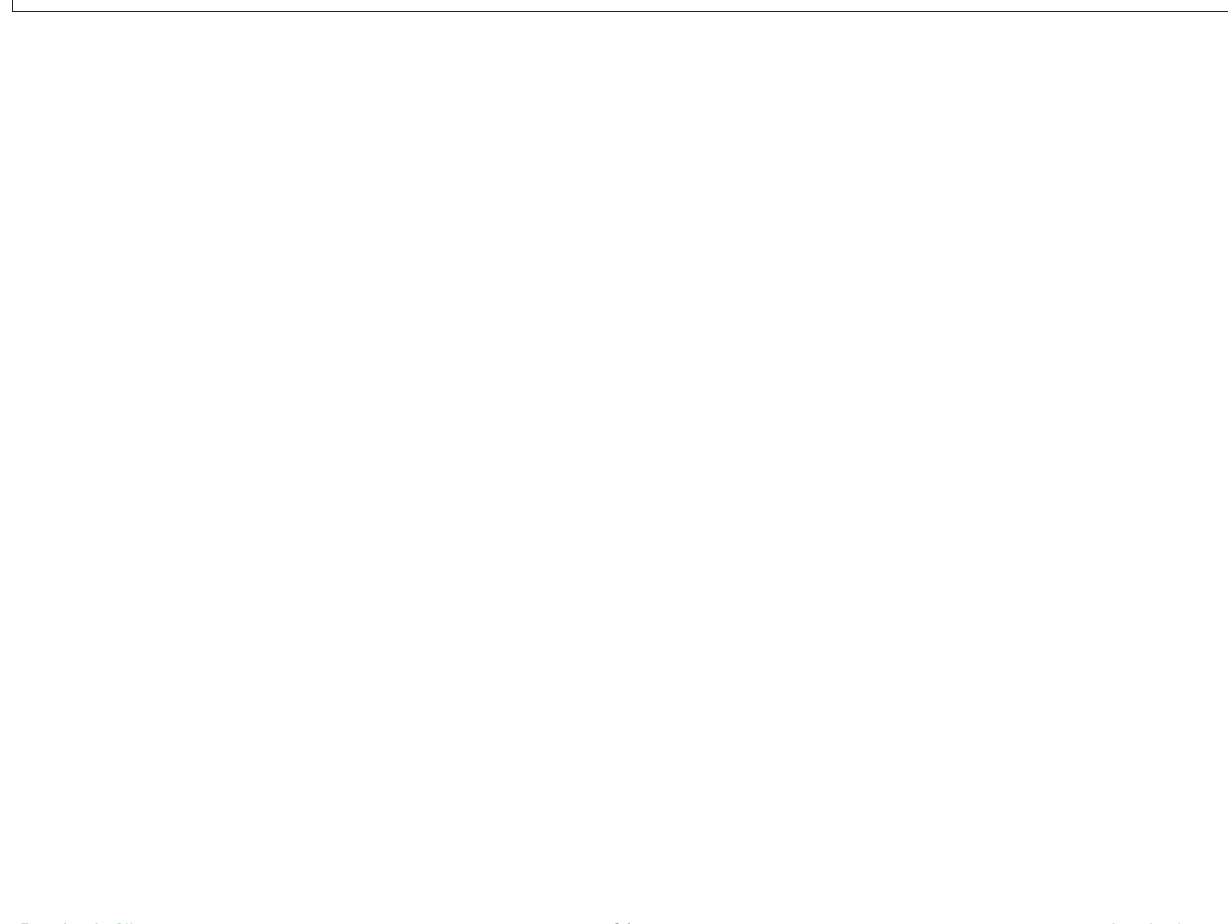
FIGUREA1 Globally averaged land-surface time series of maximum and minimum temperature from